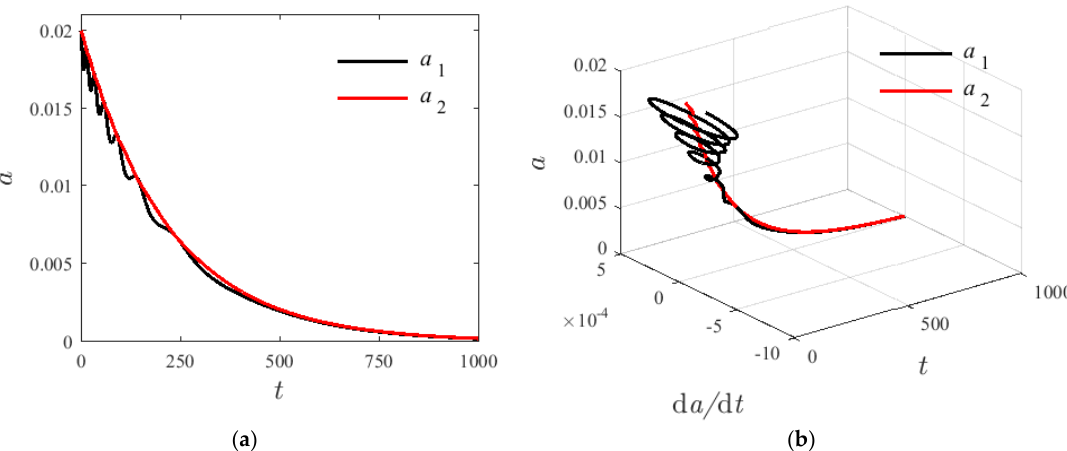
Figure 9. The coupling decay graphs of variation modes; ( a ) time-history response diagrams ( b ) 3D response diagram.